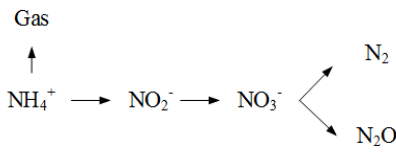
Figure 1. Expression of trinitrogen chain reaction.